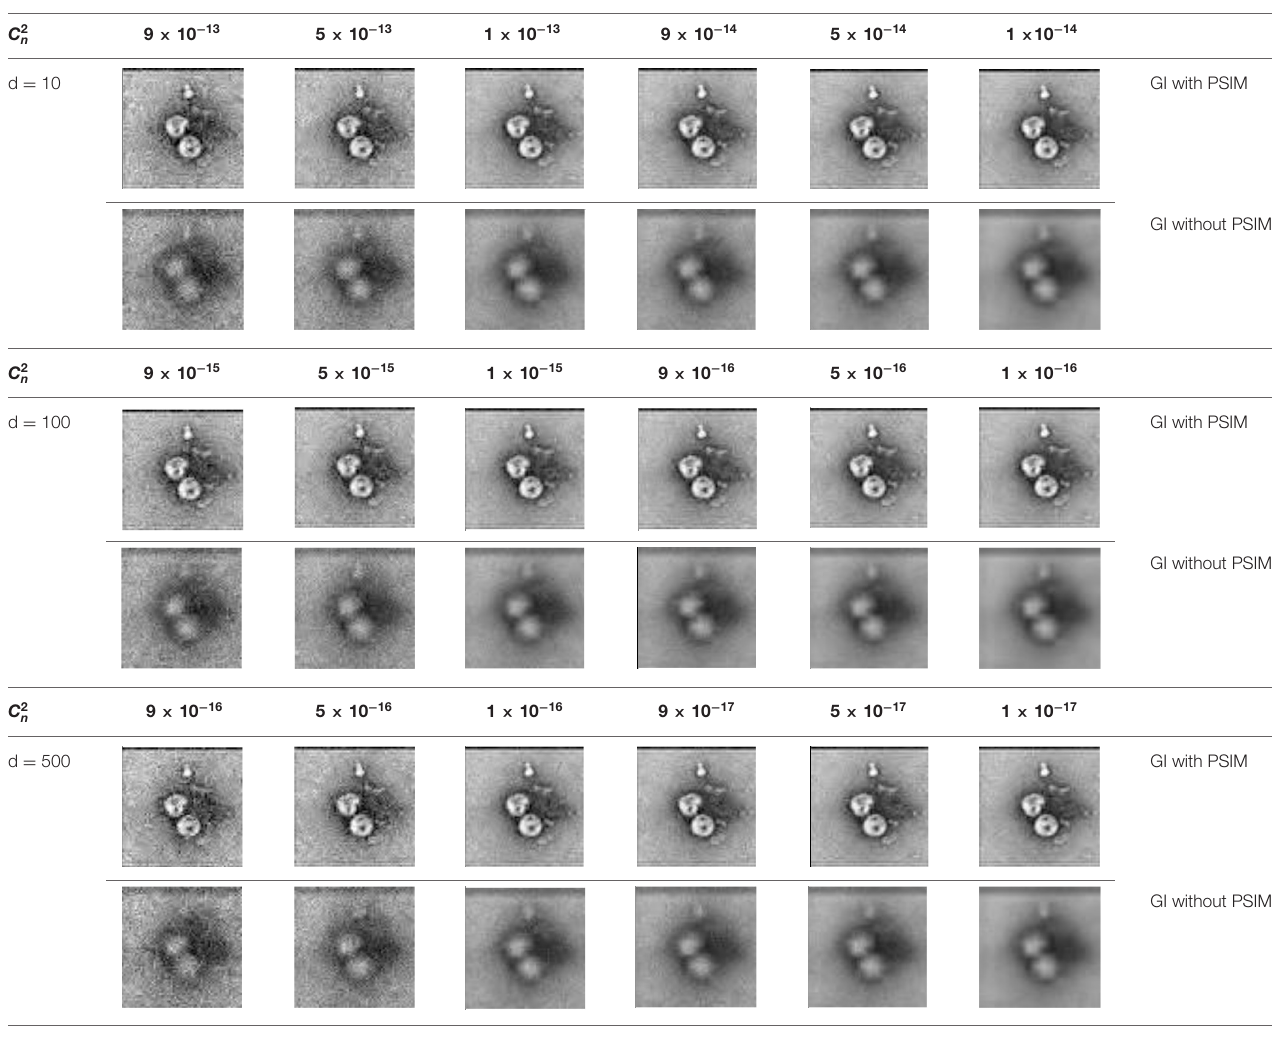
TABLE 3 | Imaging effects for different values of the refractive-index structure parameter C 2 n